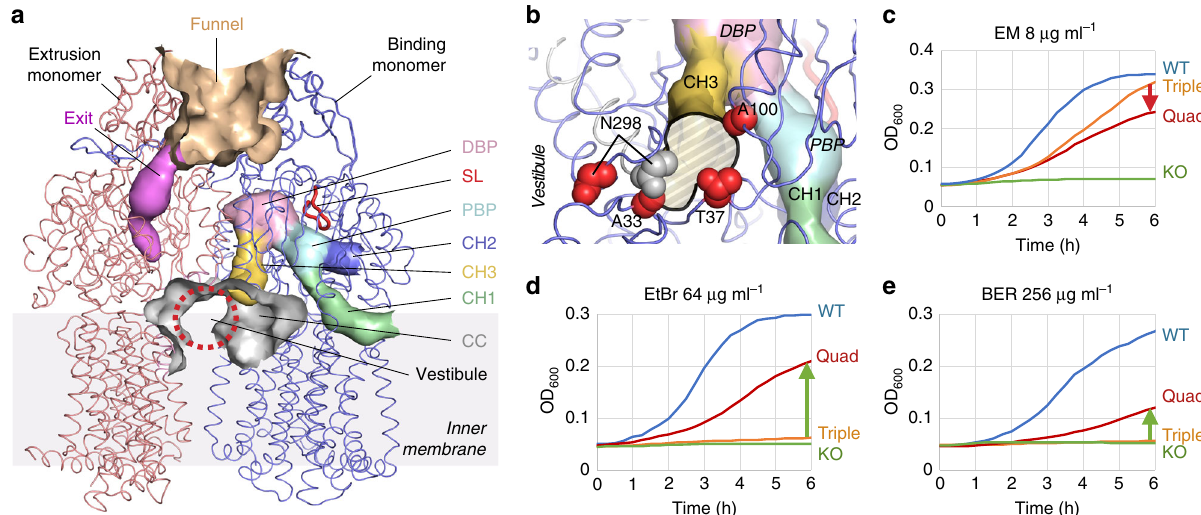
Fig. 1 Channels within AcrB and the effect of central cavity channel mutations on transport activity. a The three main supposed channels for AcrB are CH1 (green), CH2 (blue) and CH3 (yellow) drawn by CAVER 23 in the binding monomer. The access monomer in the front is deleted for a clearer view on the extrusion and binding monomers, their channels and the central cavity. Although the originally postulated CH3 14, 16 was connected to the PBP, here we show that the new more likely CH3 has a common entrance with the original CH3, but is directly connected to the DBP, bypassing the PBP and the switch- loop. The vestibule is shown by a red dashed circle and the central cavity is shown as a grey cave. For this fi gure, we used PDB 3AOD, although the channel is visible in other crystal structures of the AcrB protein. DBP distal binding pocket, PBP proximal binding pocket, SL switch-loop, CH1, CH2 and CH3, channels 1, 2 and 3, respectively; CC central cavity. b Rotated and magni fi ed view from the central cavity on the CH3 entrance. Red spheres indicate the mutation sites used in this study, depicted in the binding monomer. The grey spheres show superimposed N298 in the access monomer, where it is located near the CH3 opening. The opening is depicted as a black outlined white/grey area. c − e Growth ability of E. coli MG1655 Δ acrB expressing various CH3 mutants supplemented with erythromycin (EM) (8 μ g ml − 1 ) ( c ), ethidium bromide (EtBr) (64 μ g ml − 1 ) ( d ) and berberine (BER) (128 μ g ml − 1 ) ( e ). Colours blue, orange, red and green indicate wild-type AcrB, A33W/T37W/N298W triple mutant, A33W/T37W/A100W/N298W quadruple mutant, and vector only, respectively. Green arrows mark an increase in activity, red arrow marks a decrease in activity for quadruple compared to triple mutant AcrB. A complete overview of MIC values for the mutants can be found in Tables 1 and 2 and growth curves with other concentrations can be found in